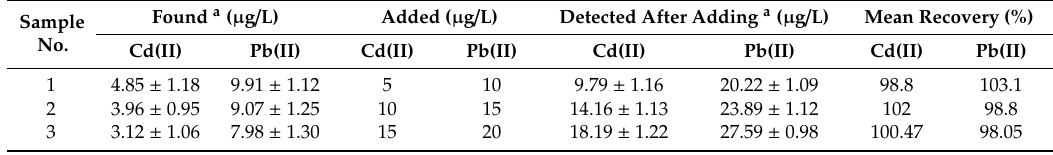
Table 2. Results of the simultaneous detection of Cd(II) and Pb(II) in synthetic water samples. Sample